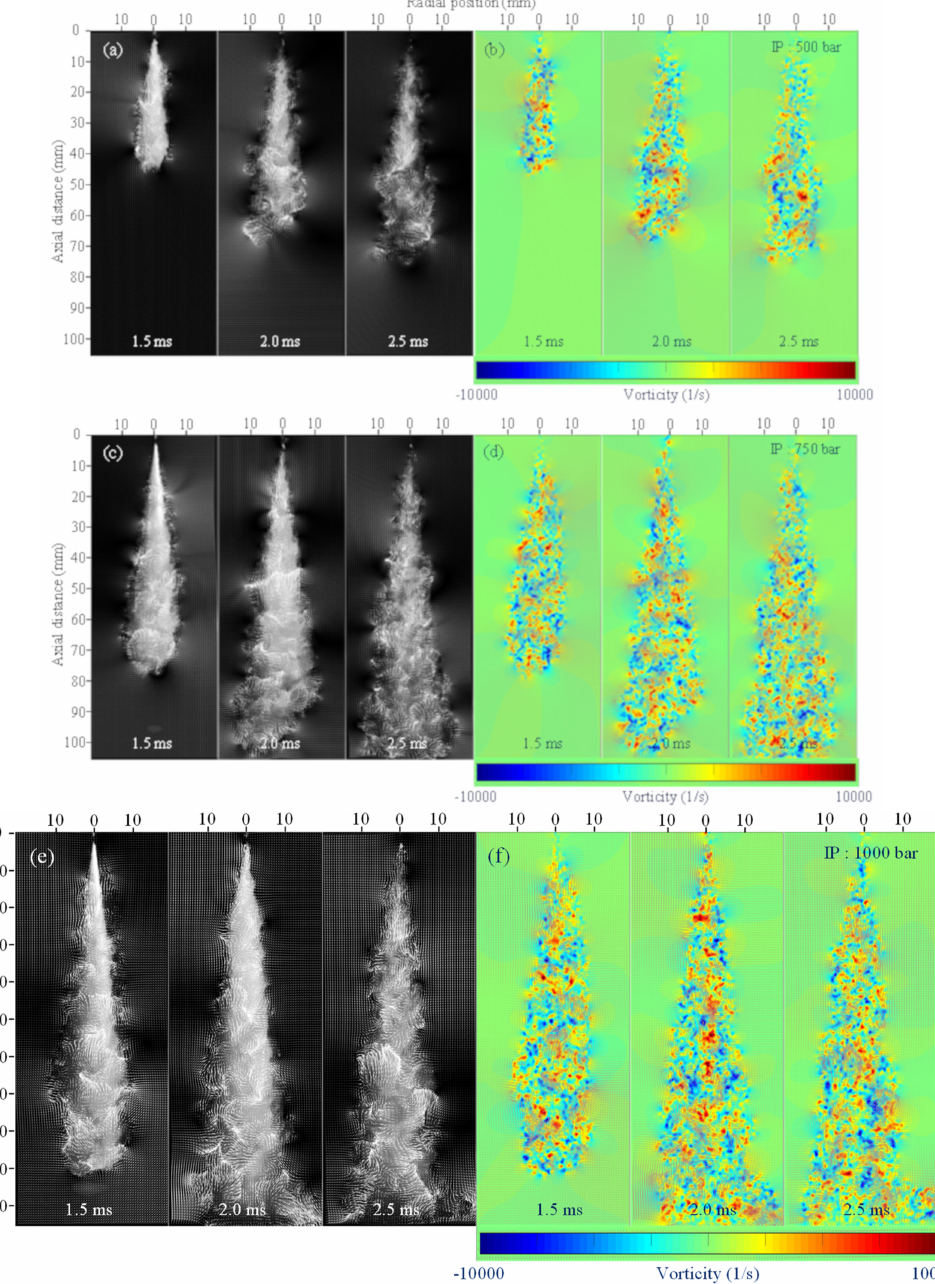
Figure 15. The vector ( a ), ( c ) and ( e ) and vorticity distribution ( b ), ( d ) and ( f ) of GB05 spray under the back pressure of 10 bar with the injection duration of 1000 µ s, and injection pressures of 500, 750 and 1000